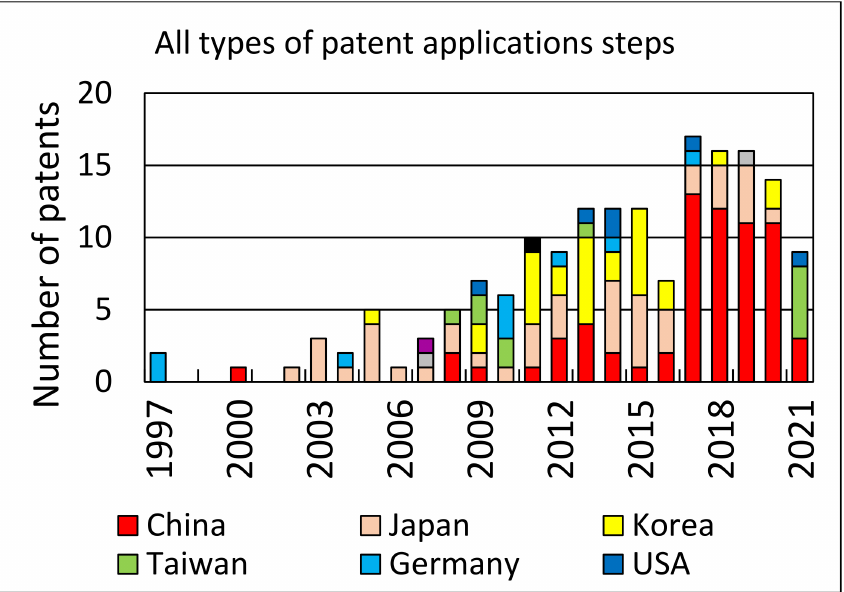
Figure 6. Distribution of the number of patents by country (all steps of a patent application process including the first step A): China—67, Japan—44, Korea—29, Taiwan—11, Germany—9,